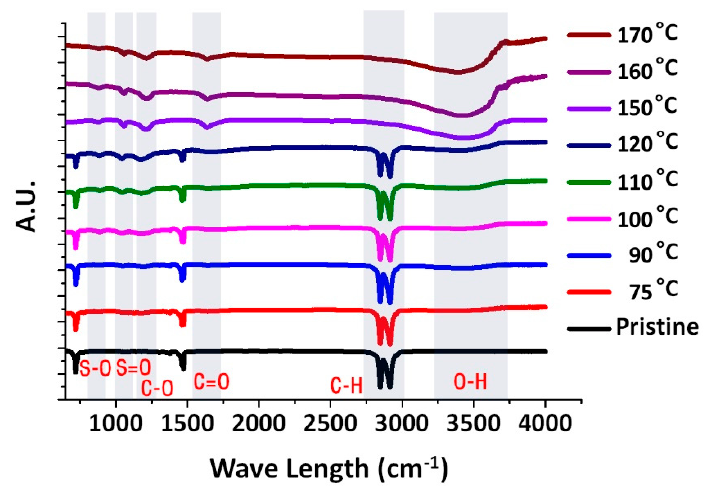
Figure 2. FT-IR results for polyethylene (PE) samples sulfonated at various temperatures.